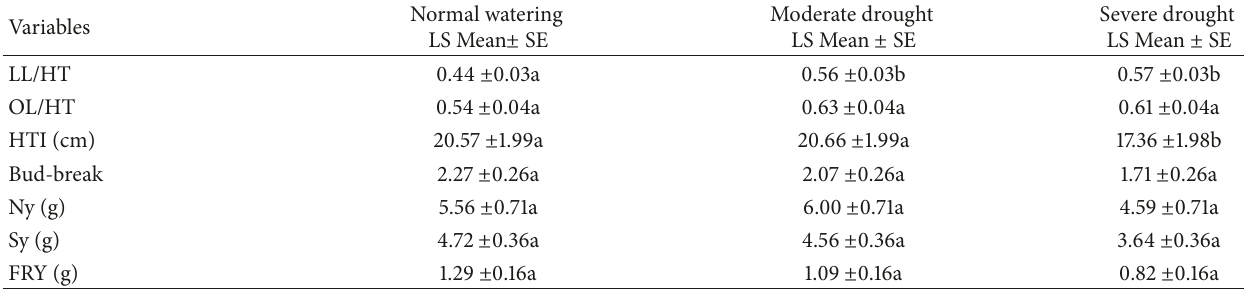
Table 4: Least square means and standard error of various response variables under three different watering conditions. Normal watering Variables